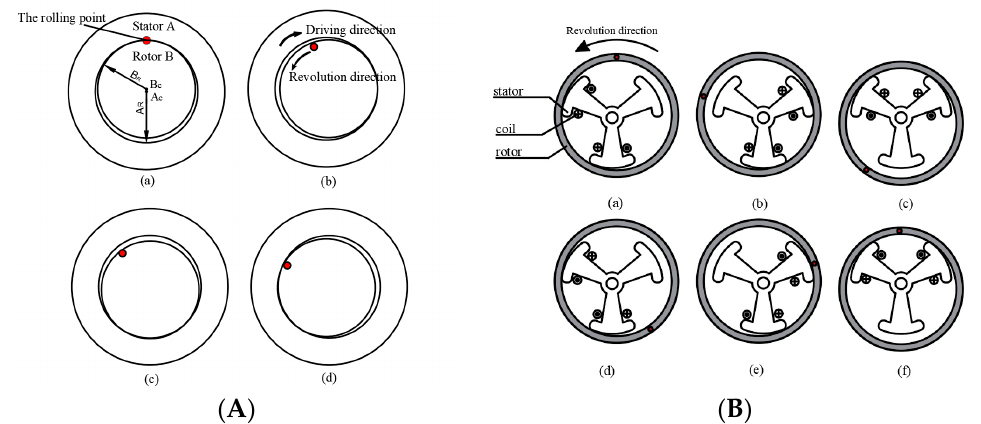
Figure 1. Driving principle: ( A ) Basic driving principle of a wobble motor; ( B ) Basic driving principle of wobble motor for a proposed gripper.